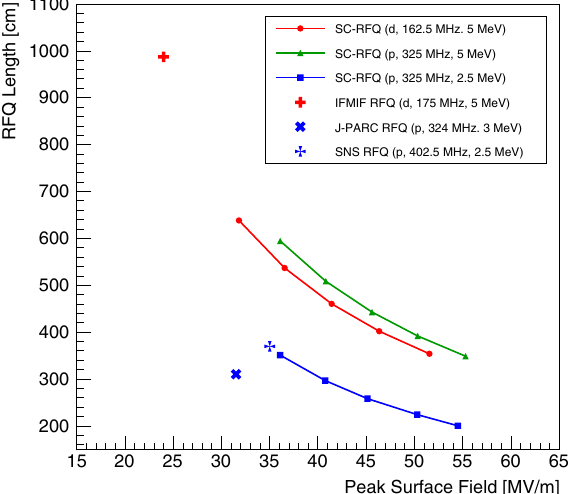
FIG. 14. RFQ length of SC cavities as a function of peak surface E-field. The vertical and horizontal axes represent the RFQ length and peak surface E-field, respectively. Moreover, the RFQ lengths of the NC cavities are plotted for